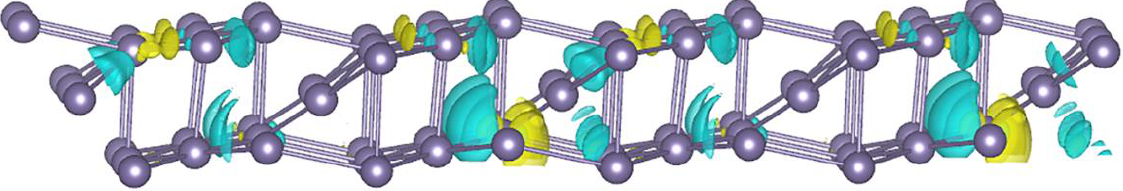
Figure 4. Localization of hole states for two holes in the 2D germanium.